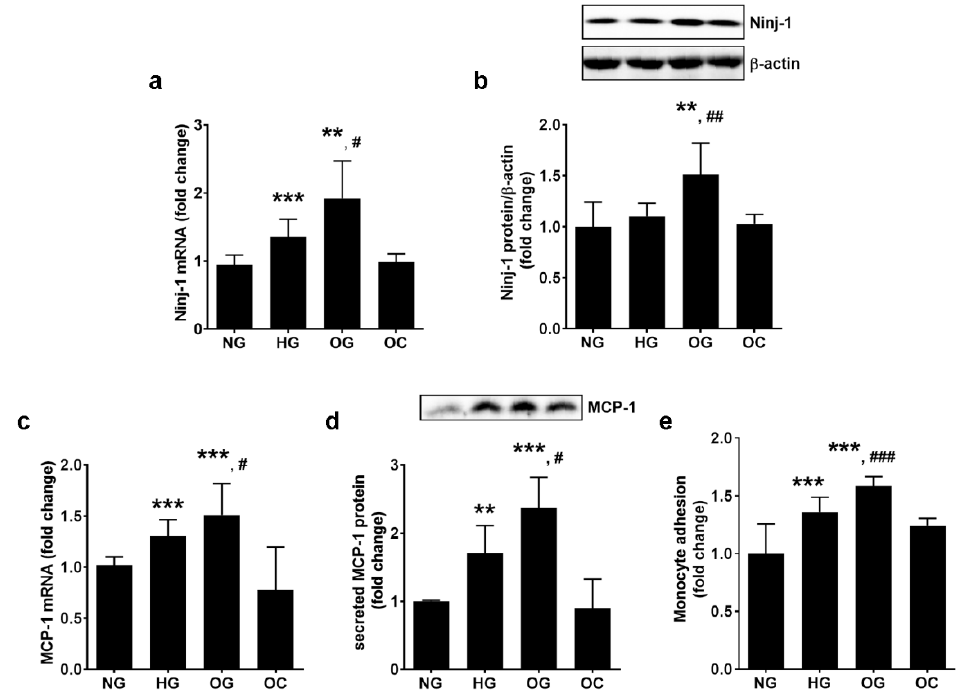
Figure 2. Oscillating glucose stimulates Ninj-1, MCP-1, and monocyte adhesion to ECs to a greater extent than HG. Cells were exposed to 5 mM glucose (NG), 25 mM glucose (HG) or alternatively to 5 mM/25 mM glucose (OG) at every 3 h, for 72 h. Cells exposed alternatively to L-glucose or mannitol (using the same protocol as for OG) was considered osmotic control (OC). ( a , c ) mRNA levels of Ninj-1 ( a ) and MCP-1 ( c ); ( b ) Ninj-1 protein expression in whole cell lysate relative to β -actin (representative blots and densitometric analysis); ( d ) secreted MCP-1 in the culture media relative to total cell protein (representative blots and densitometric analysis); ( e ) monocyte adhesion to endothelial cells. All data are expressed as fold change versus NG and presented as mean ± SD. ** p < 0.01, *** p < 0.001 vs. NG; # p < 0.05, ## p < 0.01, ### p < 0.001 vs. HG. OG determined the highest up-regulation of MCP-1 gene expression (1.51 ± 0.31 for OG, 1.30 ± 0.16 for HG, and 1.00 ± 0.07 for NG; p < 0.001 for OG vs. NG and p < 0.05 for OG vs. HG; p < 0.001 for all studied groups by ANOVA test) and of the secreted protein (2.51 ± 0.31 for OG, 1.86 ± 0.16 for HG, and 1.00 ± 0.02 for NG; p < 0.001 for OG vs. NG and p < 0.05 for OG vs. HG; p < 0.001 for all studied groups by ANOVA) (Figure 2c,d). To validate these results, a functional test for monocyte adhesion to ECs exposed to OG, HG or, NG was performed. The results showed that OG stimulated the adhesion of monocytes to ECs to a greater extent than HG (1.58 ± 0.08 for OG, 1.36 ± 0.13 for HG, and 1.00 ± 0.26 for NG; p < 0.001 for both OG vs. NG and OG vs. HG; p < 0.001 for all studied groups by ANOVA) (Figure